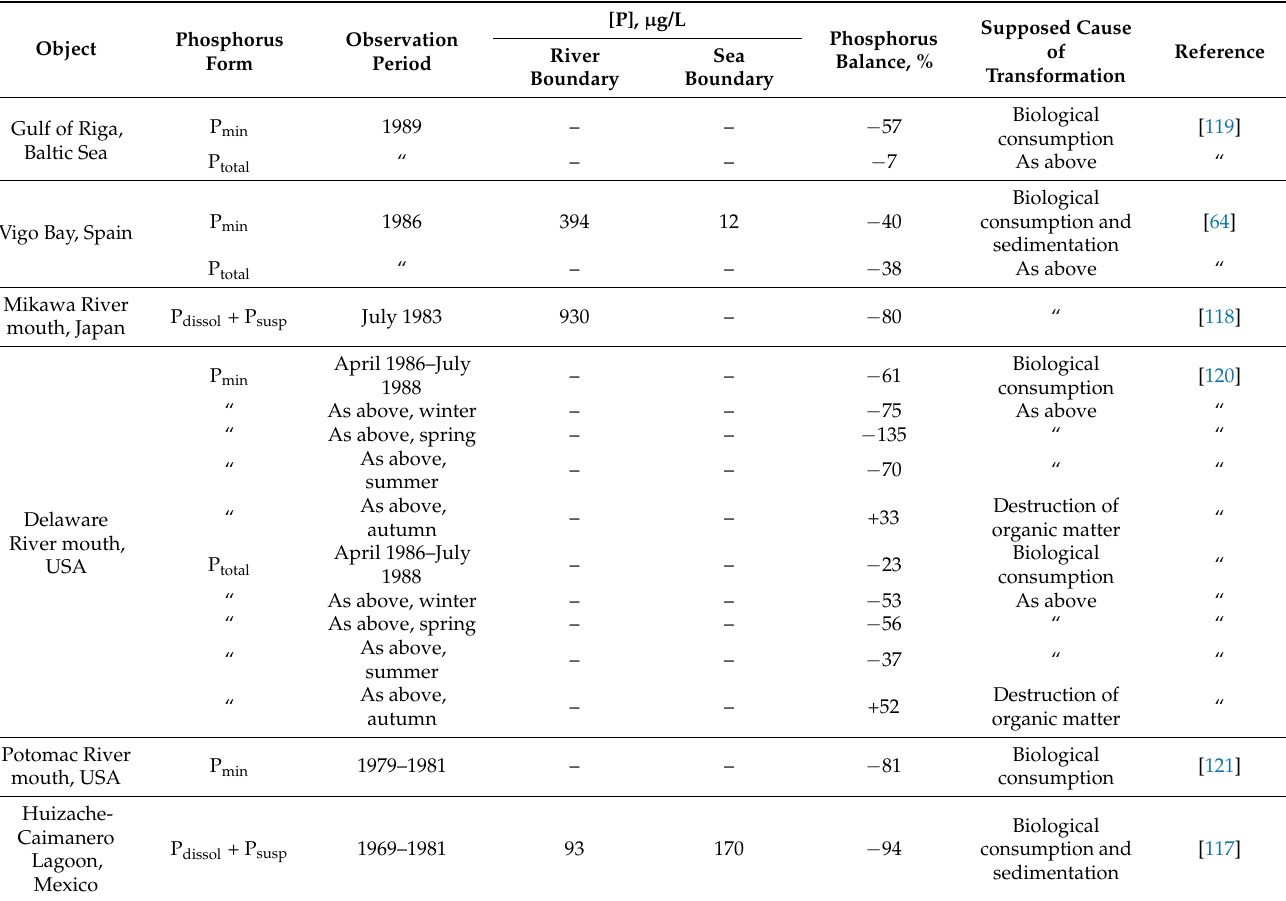
Table 17. Balance estimates of phosphorus losses in the river mouth areas and